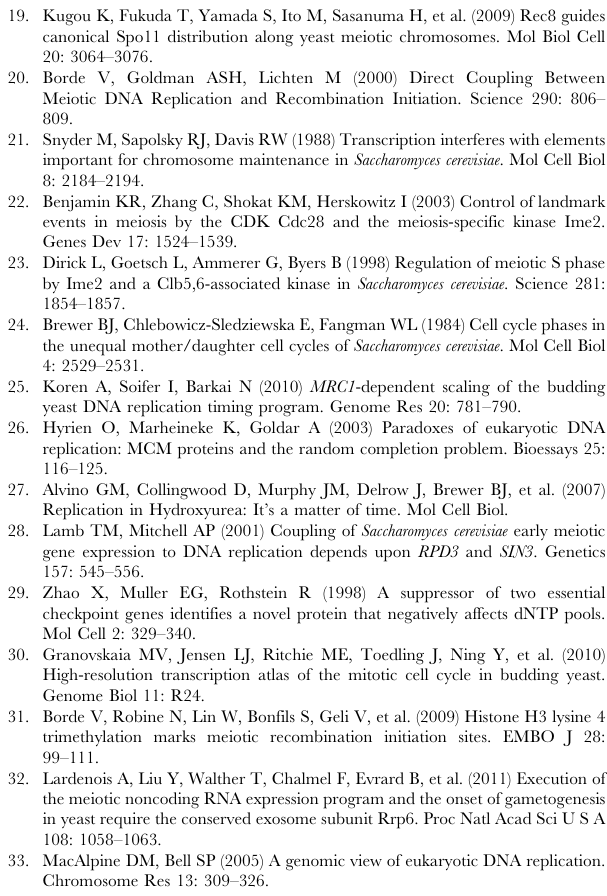
for Rec8, Hop1 and Red1 are indicated by inverted black triangles above the plots. Black dots indicate the positions of the centromere. Figure S8 ssDNA enrichment profiles. The ssDNA enrichment profiles for dmc1 D cells (blue, [67]), and dmc1 D cdc6-mn cells (H1584, orange, enrichment downwards) were plotted with respect to position for all 16 yeast chromosomes. Black dots indicate the positions of centromeres.